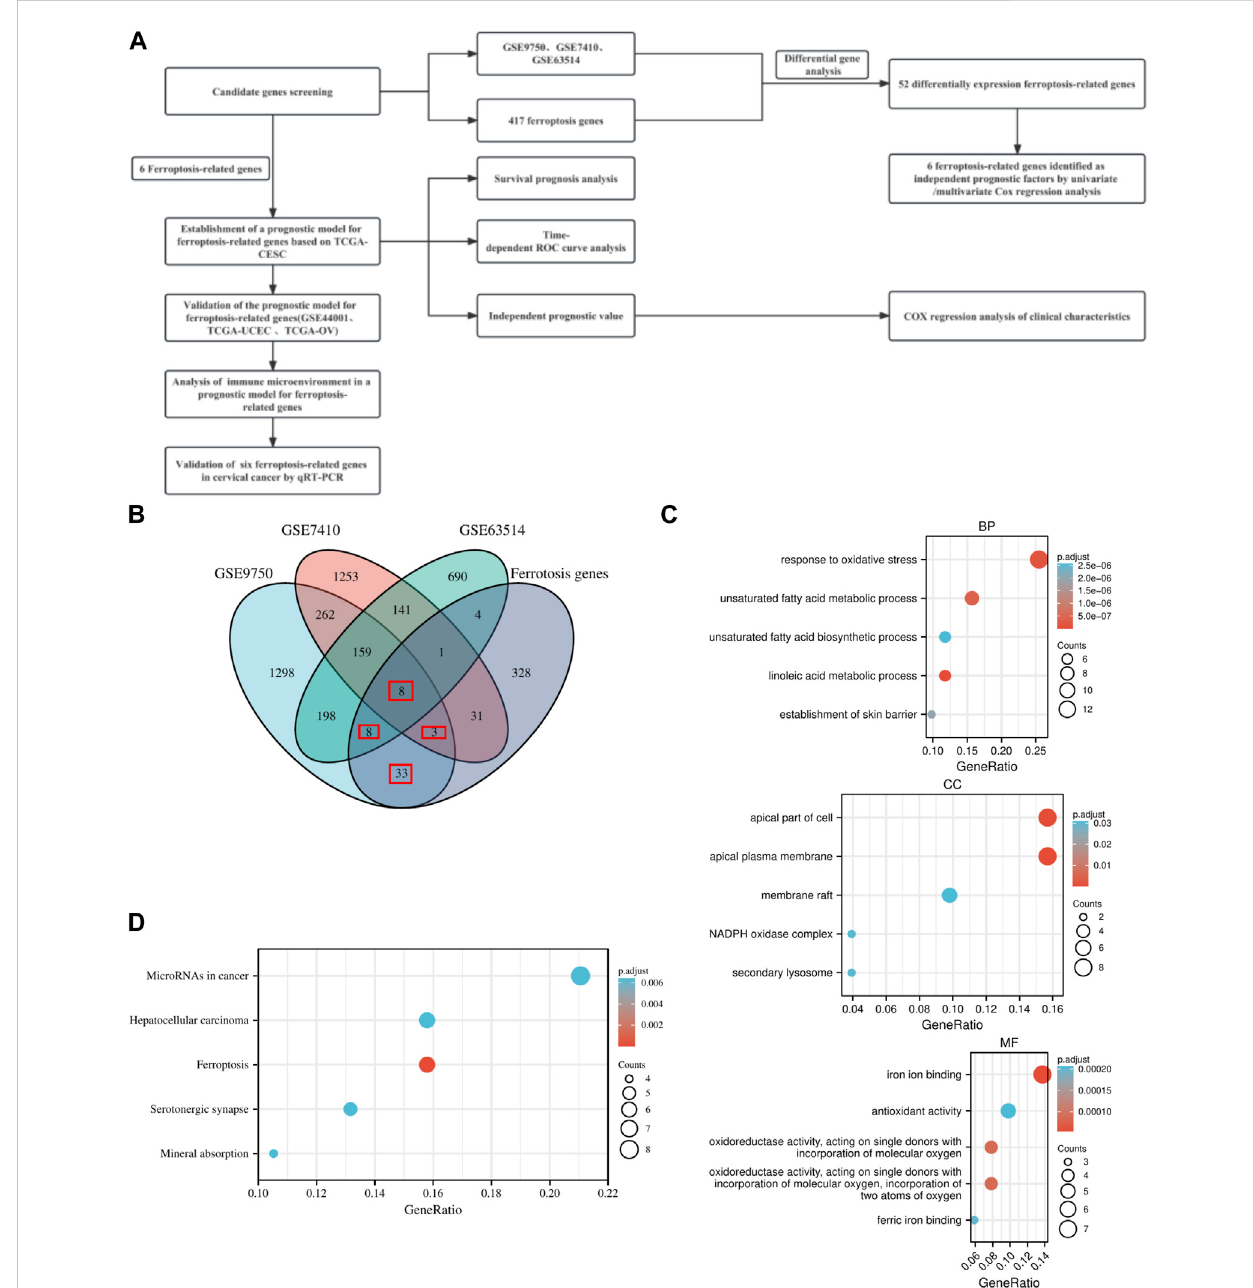
FIGURE 1 Research plan andOverviewof FRGssignatures . (A) Researchplan. (B) Venn diagramof differential genesand ferroptosis genes. (C) GO enrichment analysis of ferroptosis-related genes in BP, CC, and MF. (D) KEGG pathway enrichment analysis of ferroptosis-related